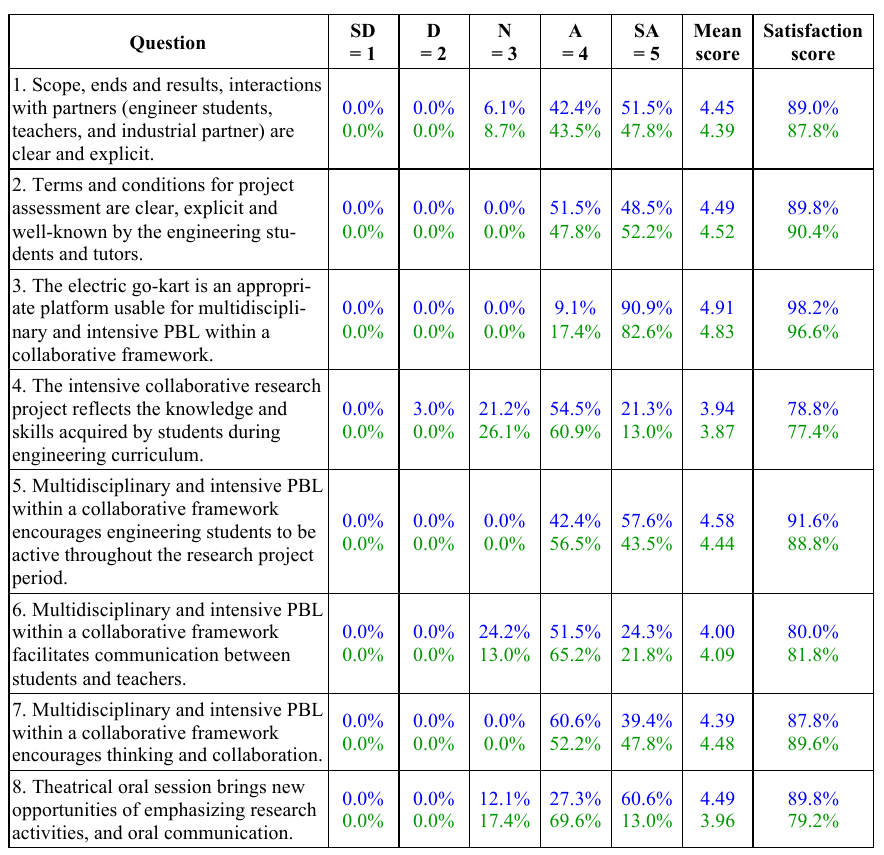
Table 3. Satisfaction survey summary from Likert Scaling. The students‘ results of the Class of 2016 (33 students were surveyed) and the Class of 2017 (23 students were surveyed) appear in blue and green ,